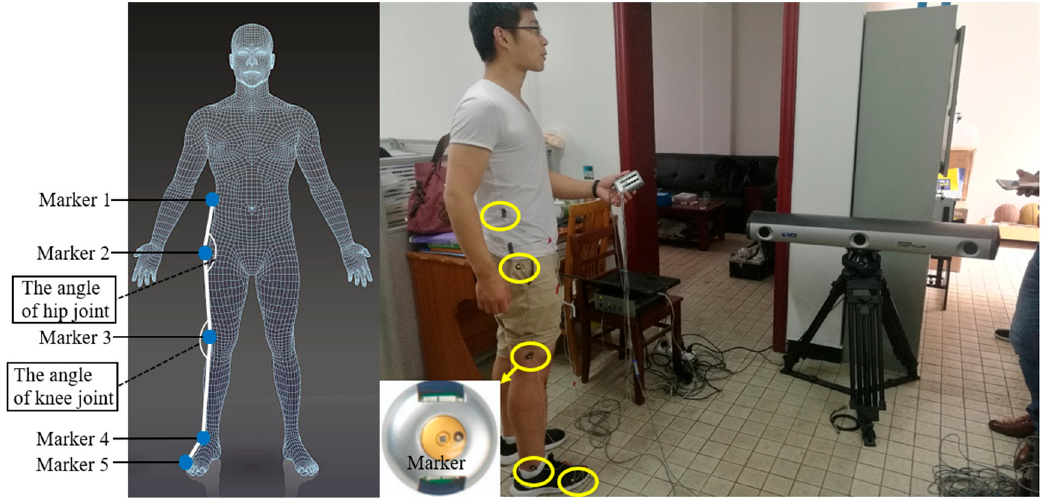
Figure 5. The layout diagram of markers ( left ) and gait capture scene ( right ).